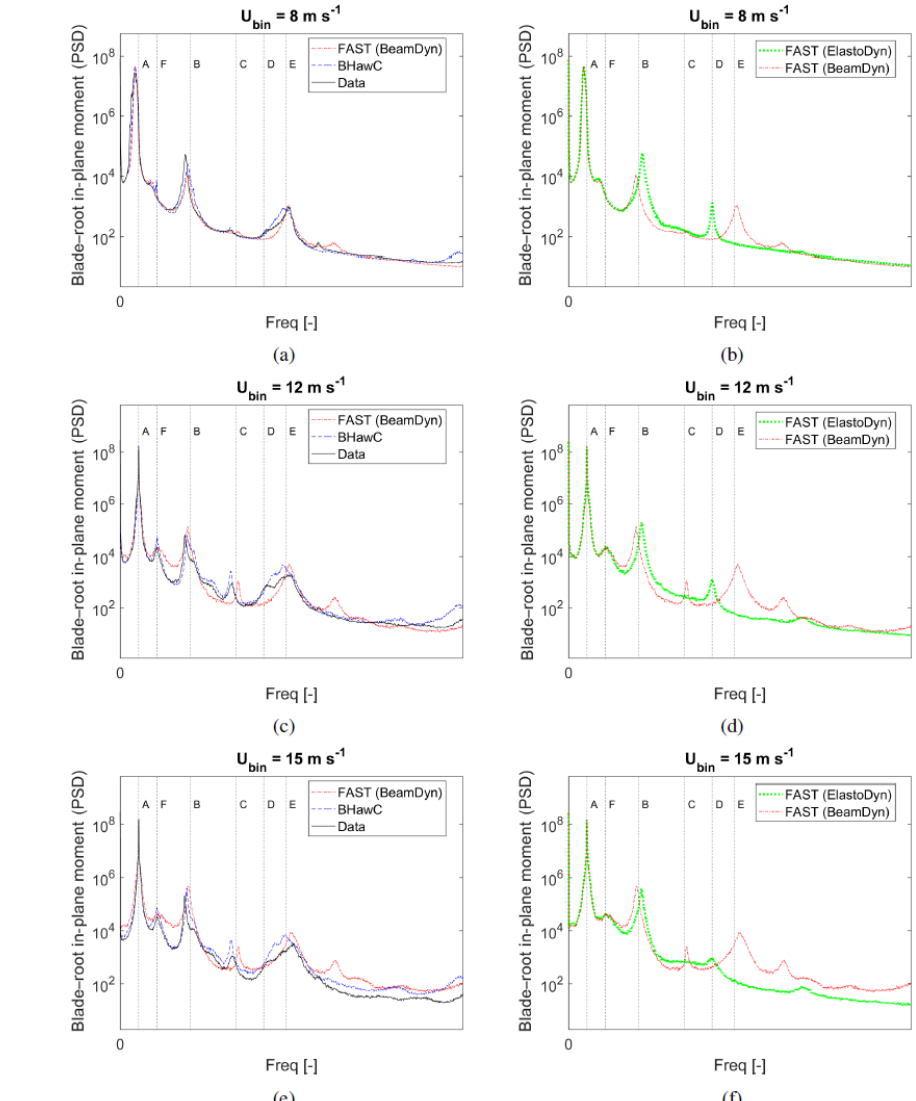
Figure 17. PSDs of the blade-root in-plane bending moments. The three sets of graphs represent the ensemble-averaged PSDs from the inflow velocity bins at 8ms − 1 (top), 12ms − 1 (center), and 15ms − 1